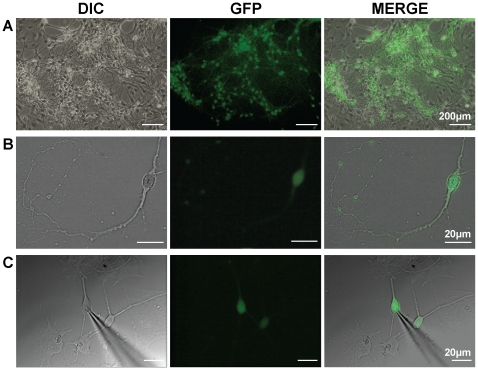
TK23 embryonic stem cells differentiate into neurons expressing GFP.
A, TK23 cell cultures containing GFP+ neurons. B, Higher magnification image of a single GFP positive neuron, showing extensive processes. C, Glass microelectrode recording from a single neuron in the whole-cell configuration. DIC  =  differential image contrast; GFP  =  green fluorescent protein.